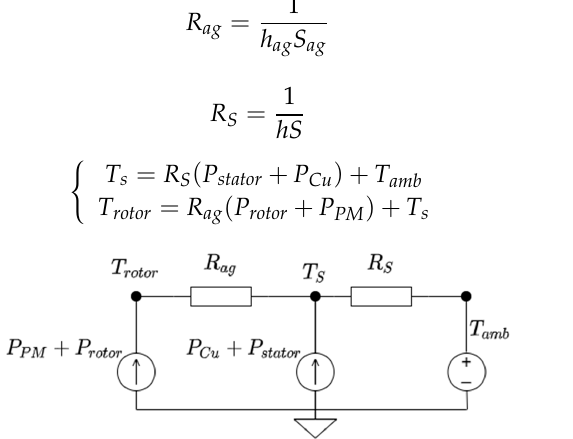
Figure 7. Thermal circuit used to estimate the maximum operating temperature during